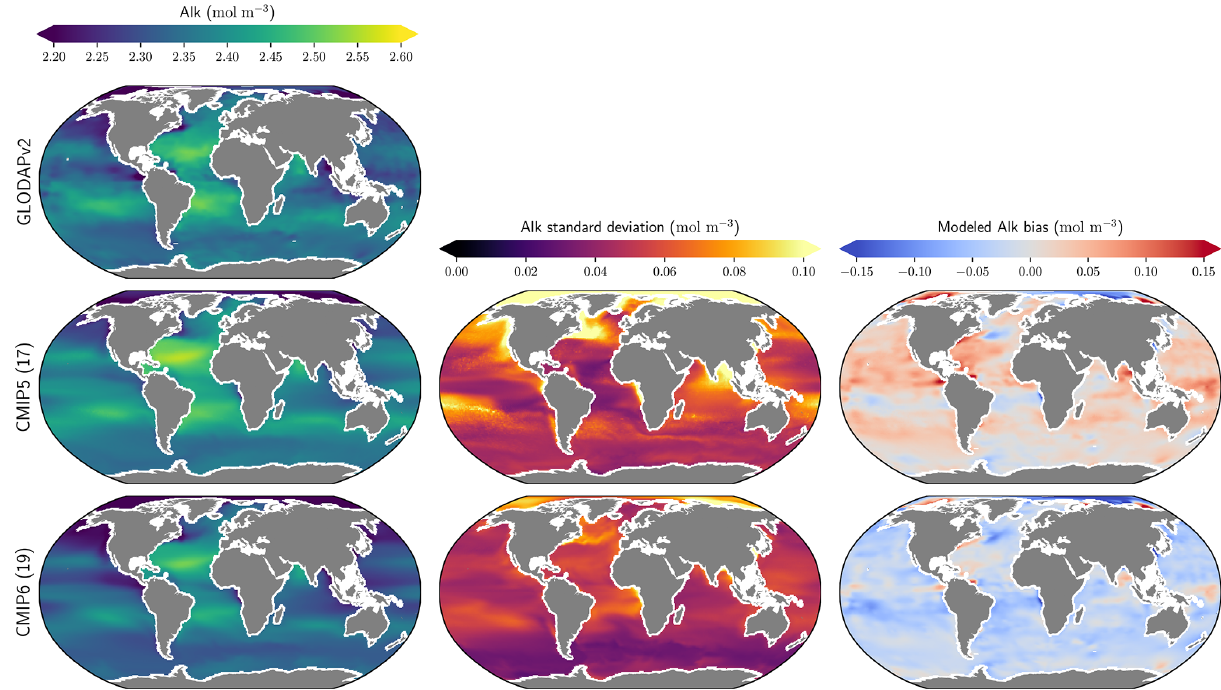
Figure 3. Alk surface distribution. The open-ocean surface Alk simulated in CMIP5 and CMIP6 compared to GLODAPv2 observations. For each CMIP ensemble, the multi-model mean, standard deviation and observational bias are